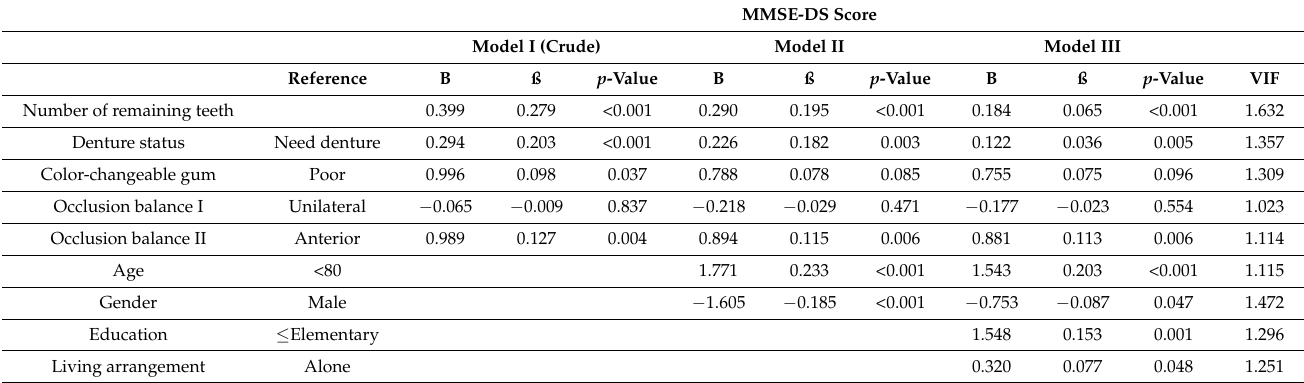
Table 4. Multiple linear regression analysis of chewing ability and cognitive